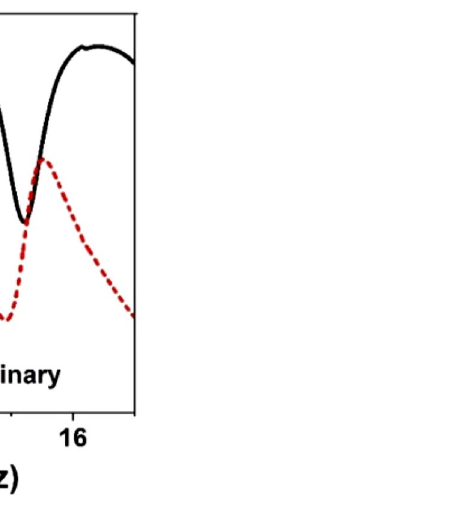
Figure 21. Relative permeability, µ r of the unit